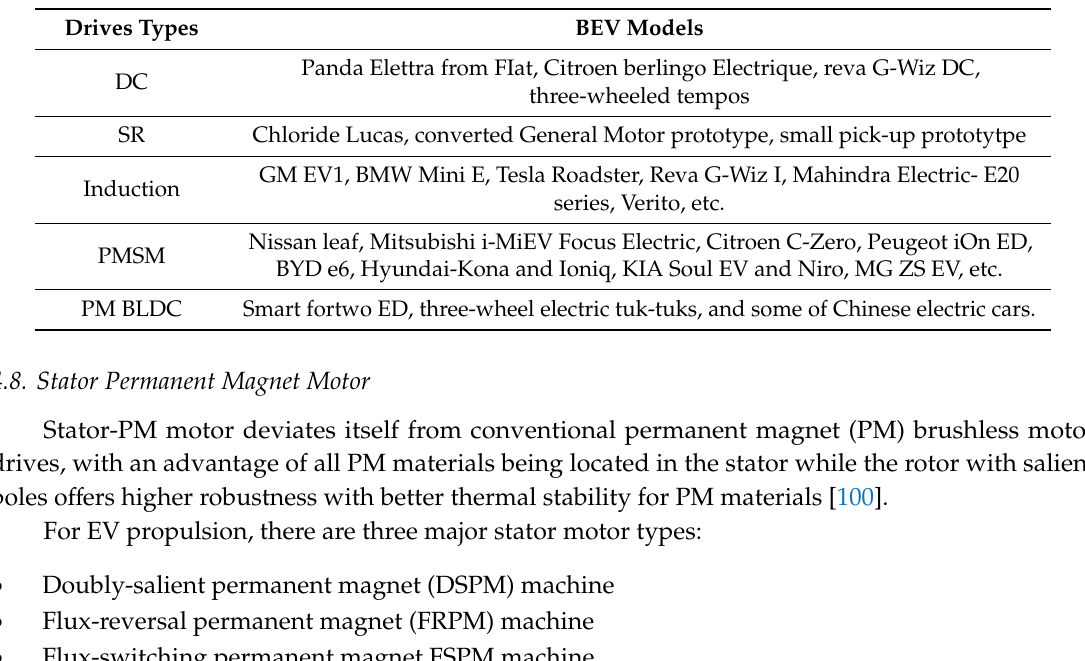
Table 2. Application of existing drives in BEV (car /